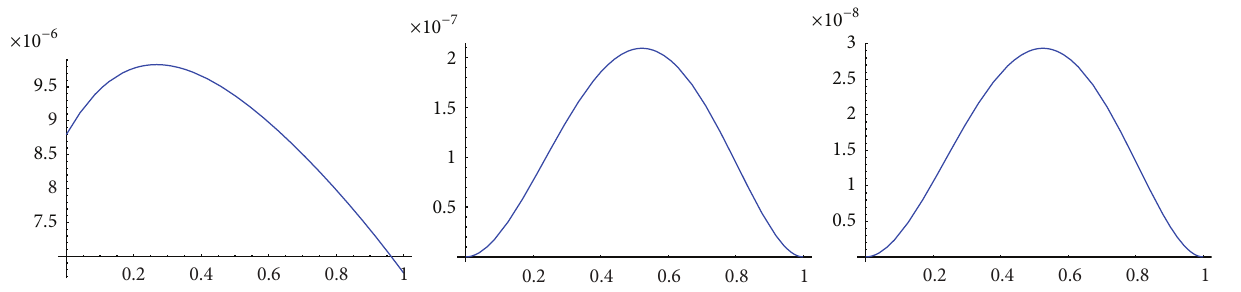
Figure 2: R.M.S of the exact solution 𝑦 𝑘 (𝑥) and the approximate solution 𝑦 𝑘 𝑛 (𝑥) ( 𝑘 = 0, 1, 2 ).